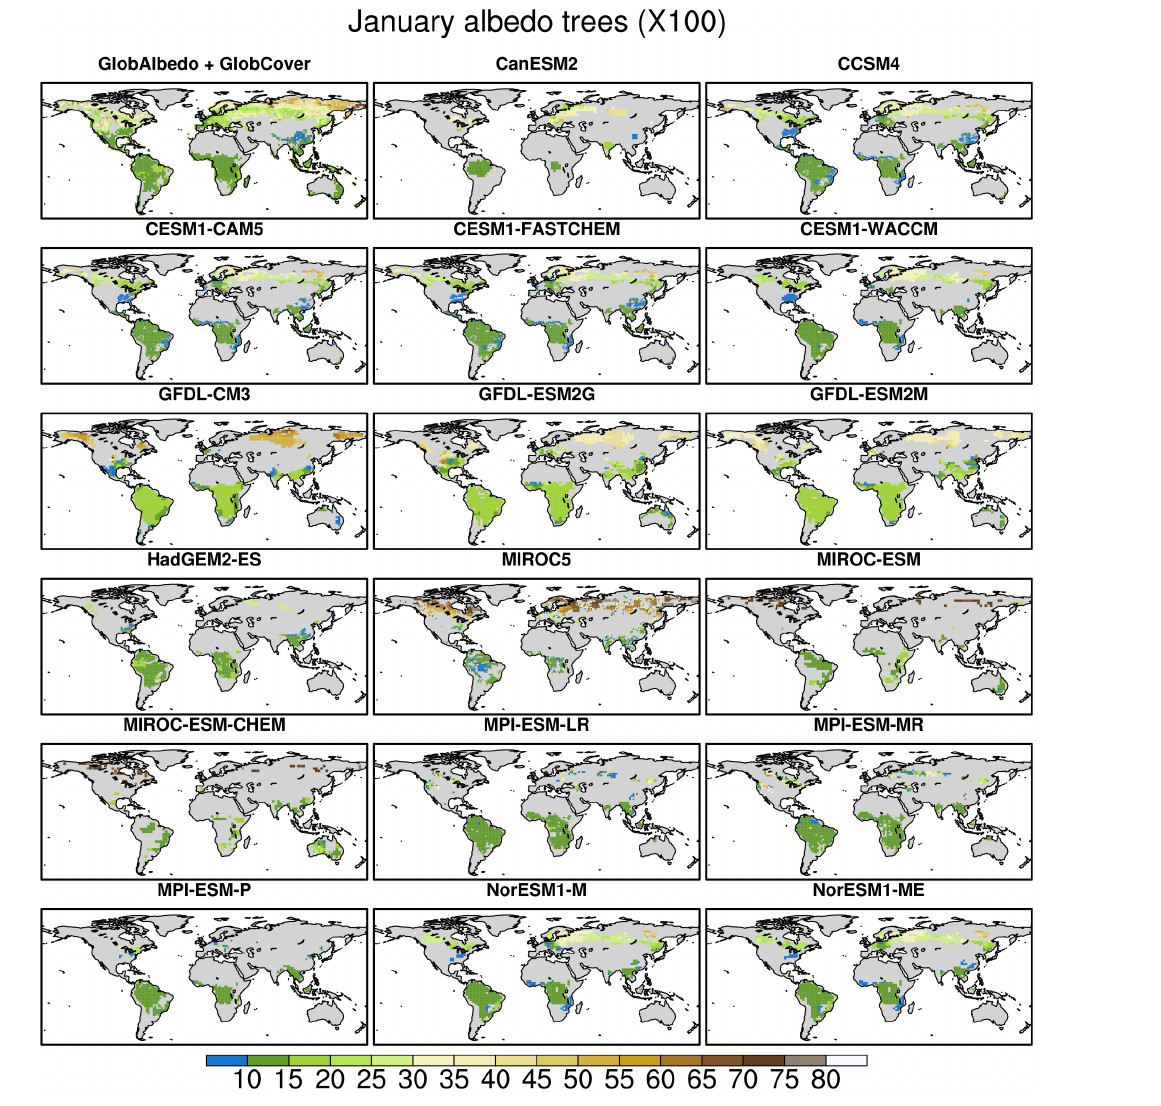
Figure 7. Same as Fig. 6, but for the month of January. Note that the scale is